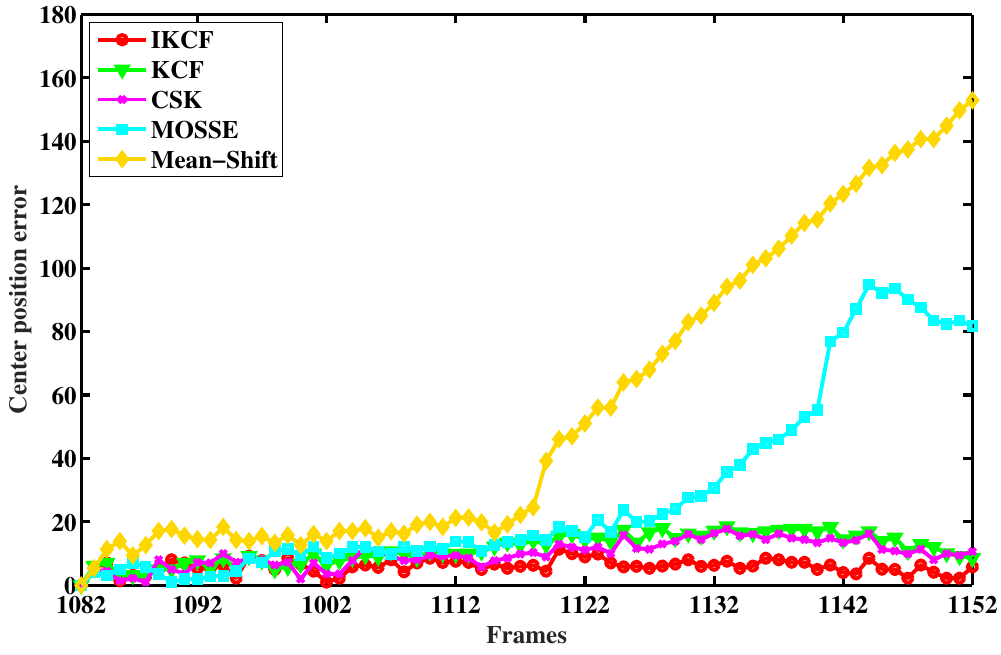
Figure 9. Center position error curves (1082nd frame to 1152nd